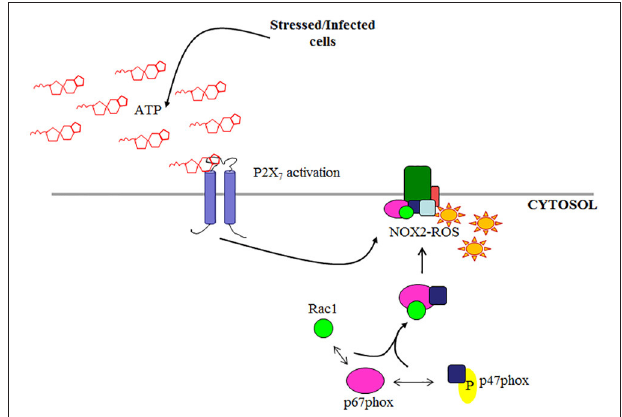
FIGURE 1 | Schematic of NOX2 complex assembly. NOX2 is activated by cytosolic subunits which are recruited to the membrane subunit gp91phox under stimulated conditions (e.g., eATP/P2X 7